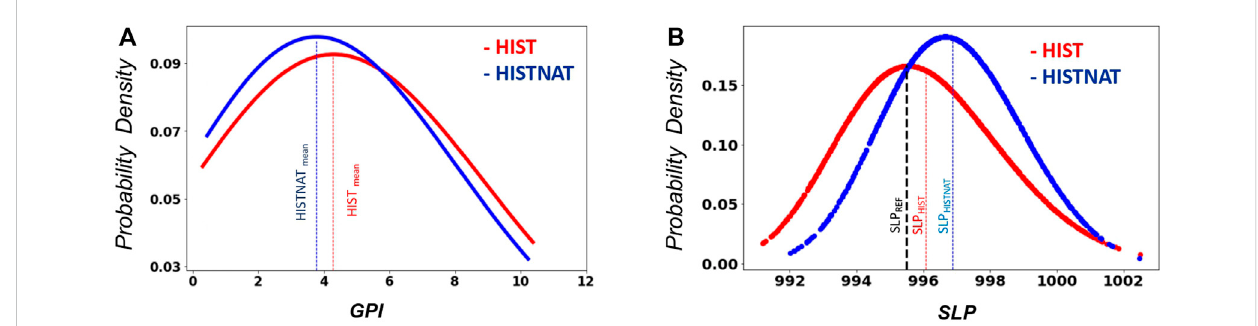
FIGURE 10 (A) Probability distribution function of GPI over WNP (120 o E – 180 o E, 5 o N – 30 o N) for HIST and HISTNAT (B) Generalized Extreme Value (GEV) distribution of extremely low SLP ( < 1 percentile) calculated over the domain (110 o E – 130 o E, 15 o N – 25 o N) for HIST and HISTNAT. The blue and red dashed lines are the mean SLP for HISTNAT and HIST, respectively. The black dashed line is the reference SLP (995.5 hPa) which corresponds to the intersection of the two GEV distribution curves.